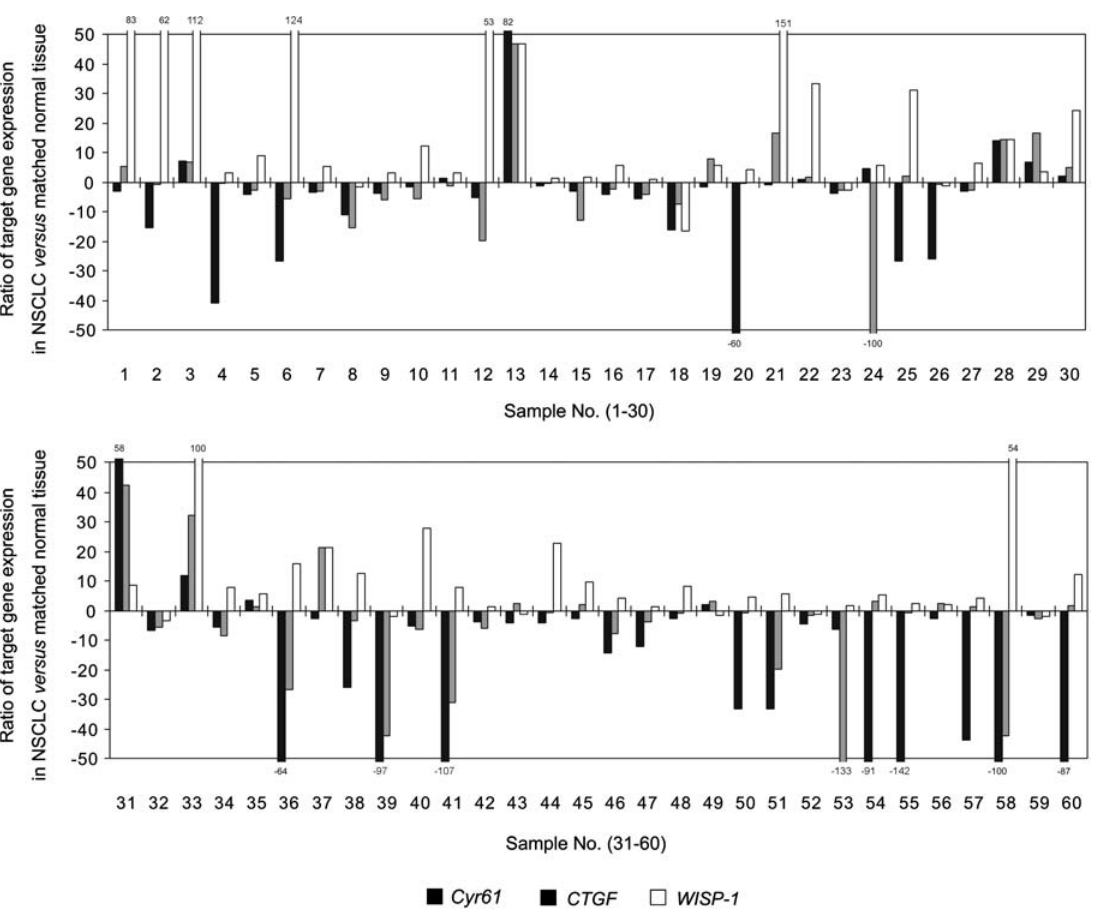
Figure 1. Expression patterns of Cyr61, CTGF, andWISP-1mRNAs in NSCLC and matched normal lung tissues. Relative mRNA expression levels of Cyr61 , CTGF , and WISP-1 are shown in 60 pairs of primary NSCLC tissues and matched normal lung samples. Expression is displayed as a ratio of expression of CCN genes in cancer versus matched normal tissues. Each bar is the log2 value of the ratio of CCN expression levels between lung tumors (T) and matched normal tissues (N) from the same patients. Less than 2-fold change: the ratio between tumor and normal is , 2. Because Log2 2=1, bar value . 1 represents . 2-fold increase (T . N), whereas bar value ,2 1 represents . 2-fold decrease (T , N).